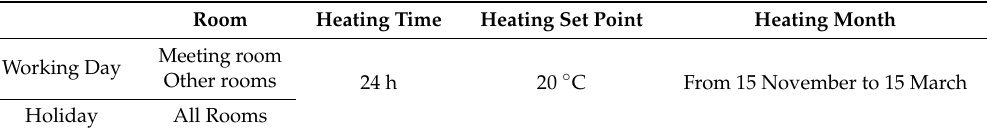
Table 11. Simulation parameters of space heating conditions in Beijing.